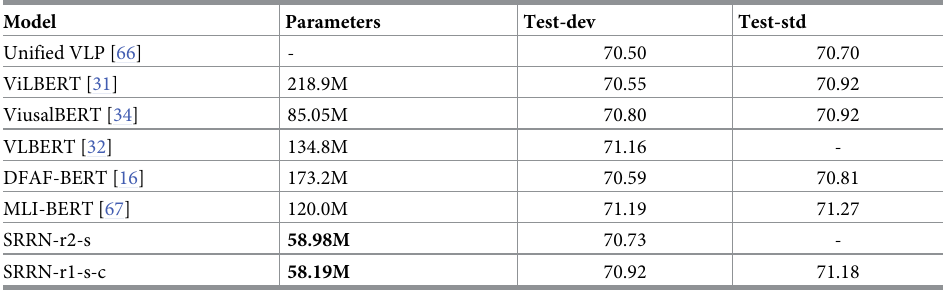
Table 3. Comparison of pre-trained model parameters and SRRN model on the VQA 2.0